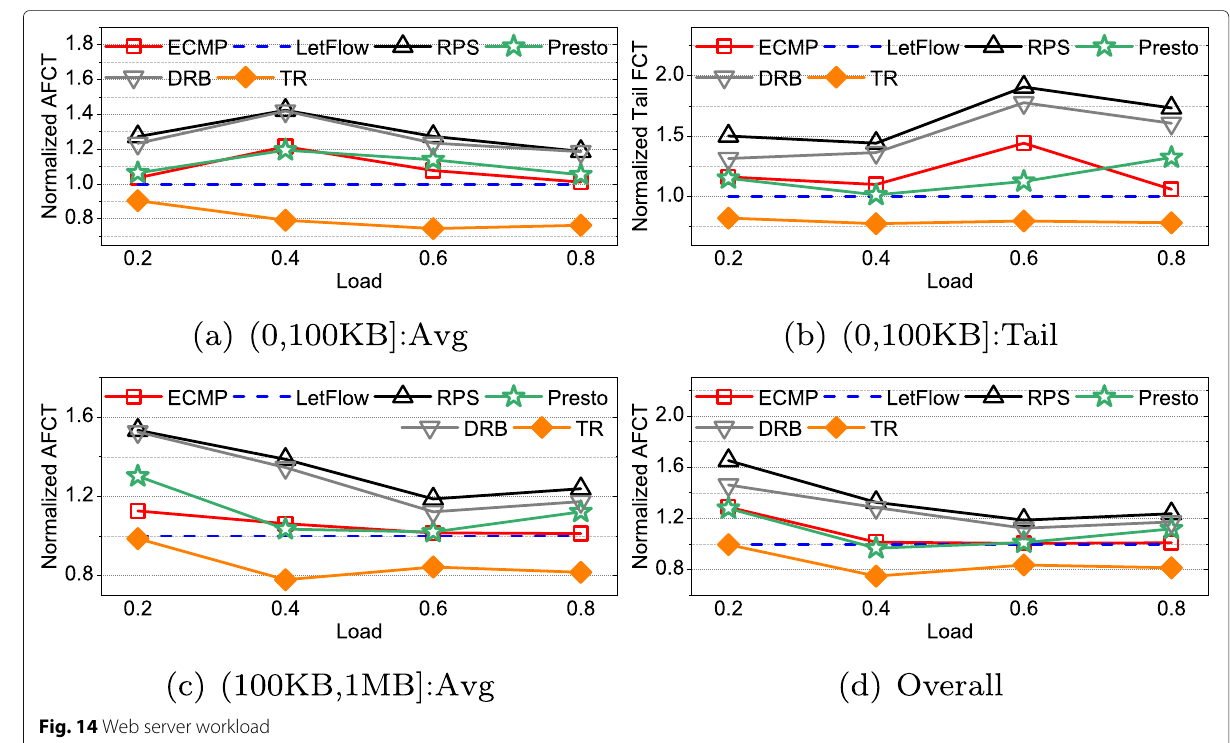
Fig. 14 Web server